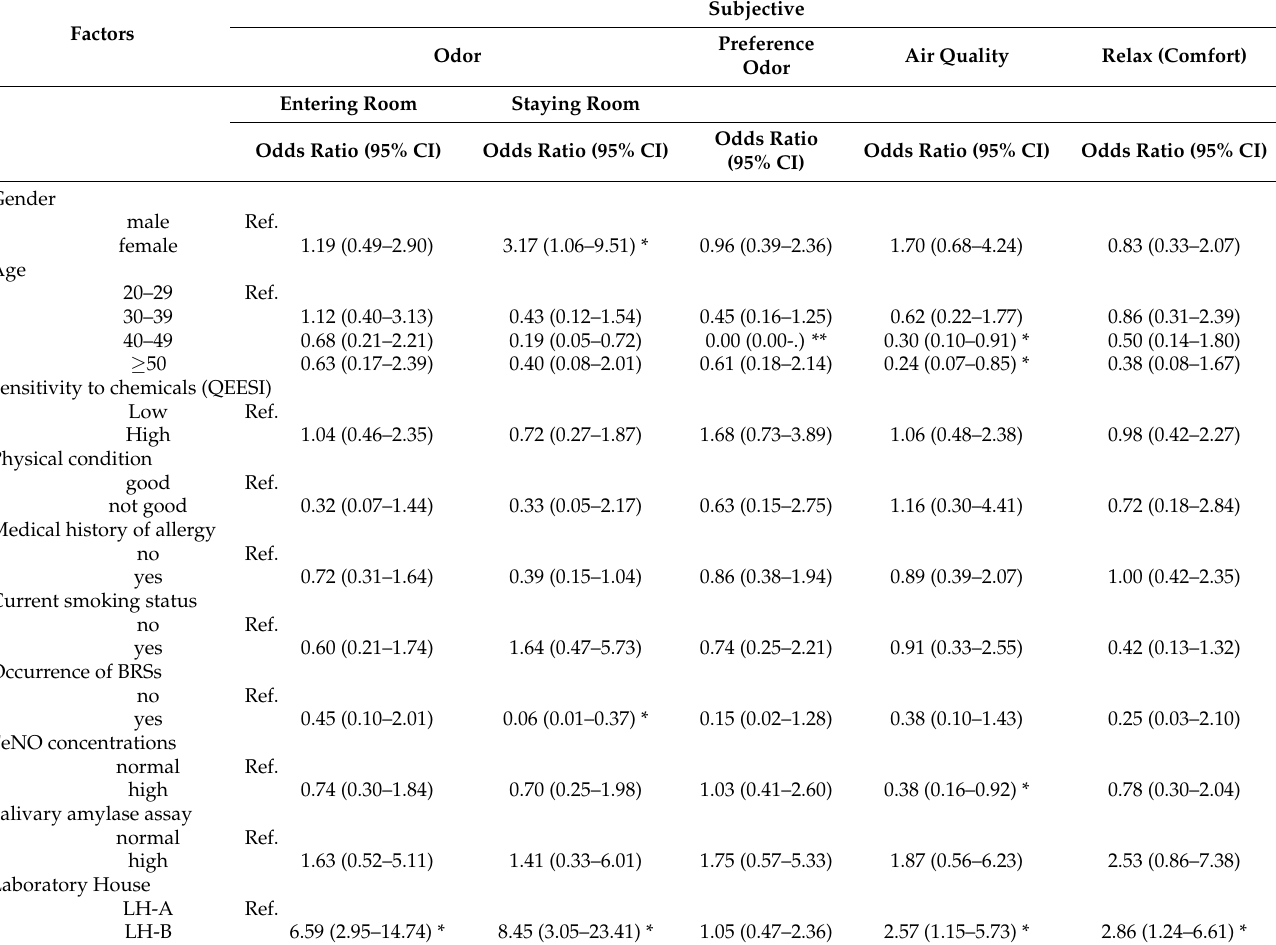
Table 4. Results of logistic regression on the associations between subjective evaluation and personal and environmen- tal